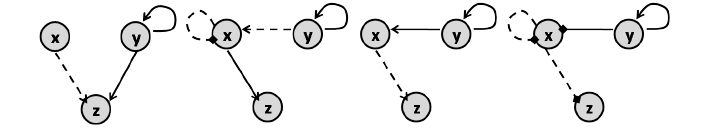
Figure 12. Set of the motifs that according to [41] leads to antagonism for a 2-drug mixture. Solid lines represent the target links of the